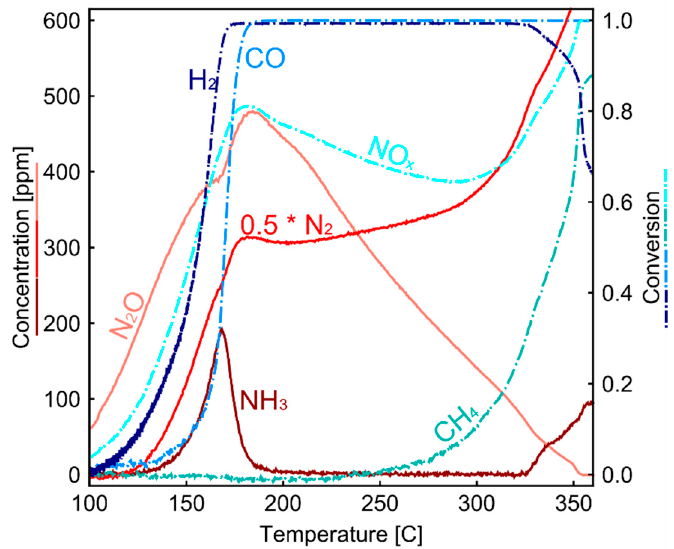
Figure 9. Temperature and Concentration profiles during temperature programmed reaction in model gas reactor.